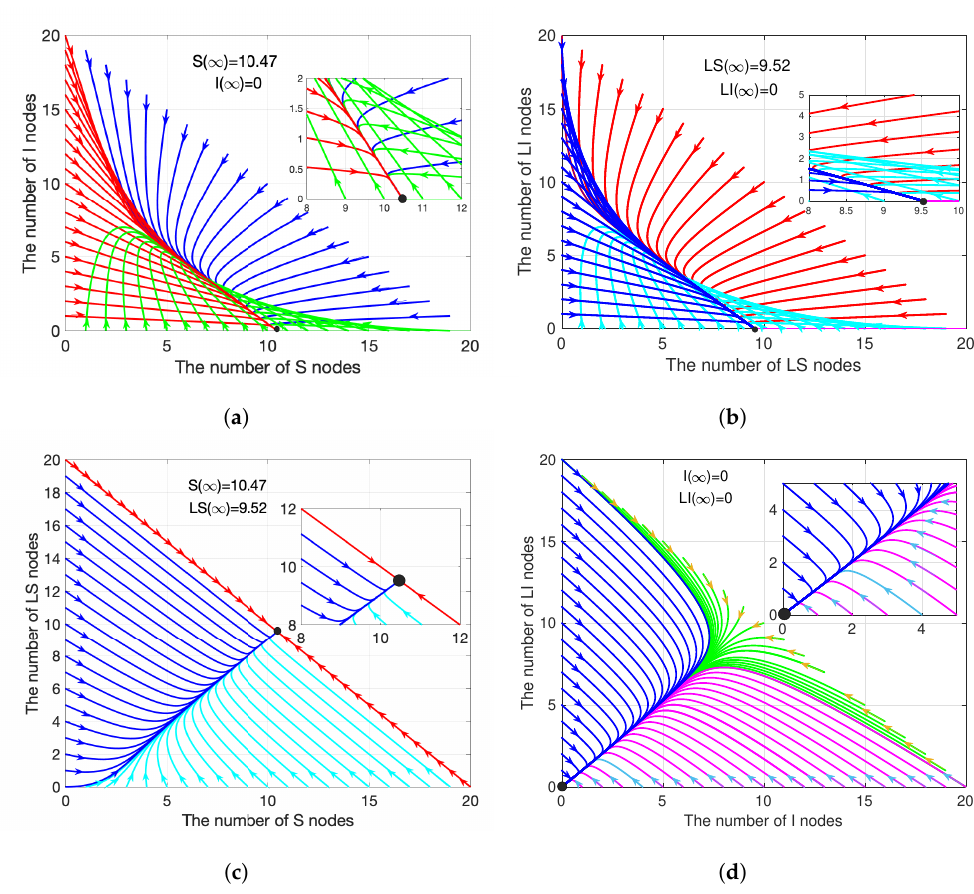
Figure 2. Evolution of sensor nodes when R 0 < 1. Different colors indicate that the curves start at different boundaries. So do Figures 3–5.